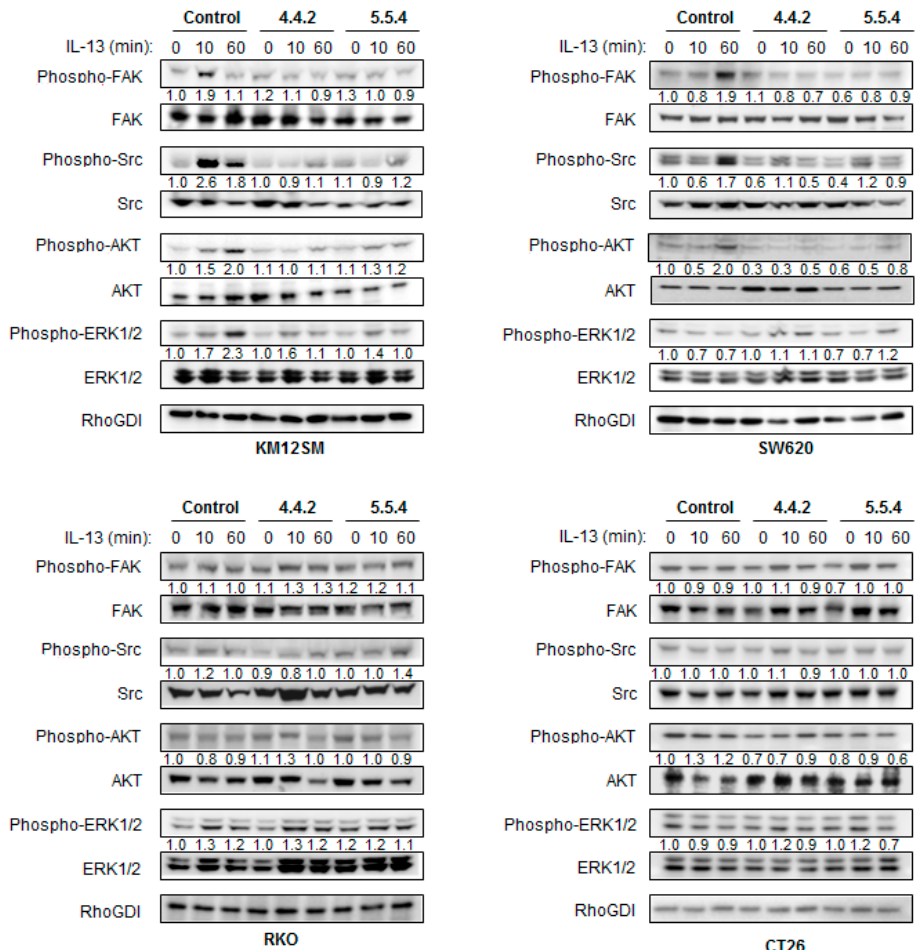
Figure 4. Molecular pathway analysis of cell signaling inhibition by IL13Ra2 D1-specific antibodies. KM12SM, SW620, RKO and CT-26 colorectal cancer cell lines were treated with IL-13 for the indicated times in serum-free DMEM in absence or presence of IL13R α 2 D1-specific mAbs. Cell extracts were collected at the indicated times and analyzed by western blot with antibodies against FAK, SRC, AKT, ERK1/2 and their phosphorylated forms. RhoGDI was used as a loading control. Bands were quantified and normalized with respect to untreated condition. IL13R α 2 D1-specific antibodies inhibited phosphorylation of IL-13/IL13R α 2 signaling mediators in a time and cell type-dependent